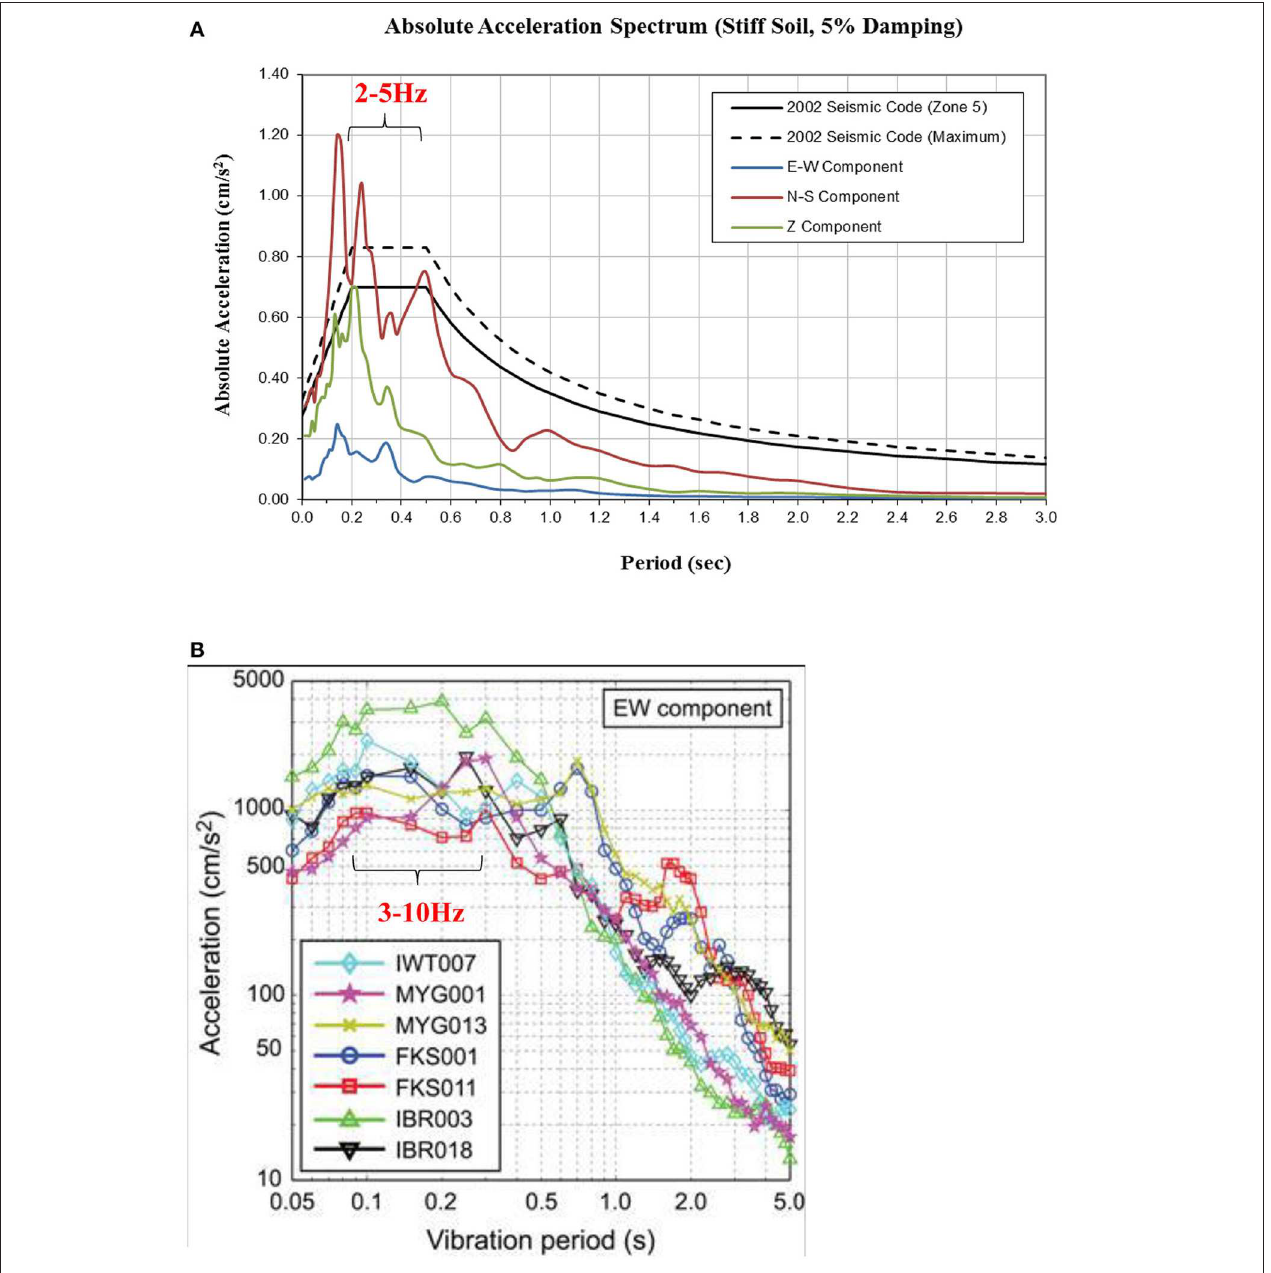
FIGURE 5 | Response spectra of Padang and Tohoku earthquakes. (A) 2009 Padang earthquake response spectra vs. uniform hazard response spectra of Indonesian seismic code [Earthquake Engineering Field Investigation Team (EEFIT), 2009]. (B) Elastic response spectra of the recorded mainshock gorund motions, East-West component at the seven K-NET station [Earthquake Engineering Field Investigation Team (EEFIT),